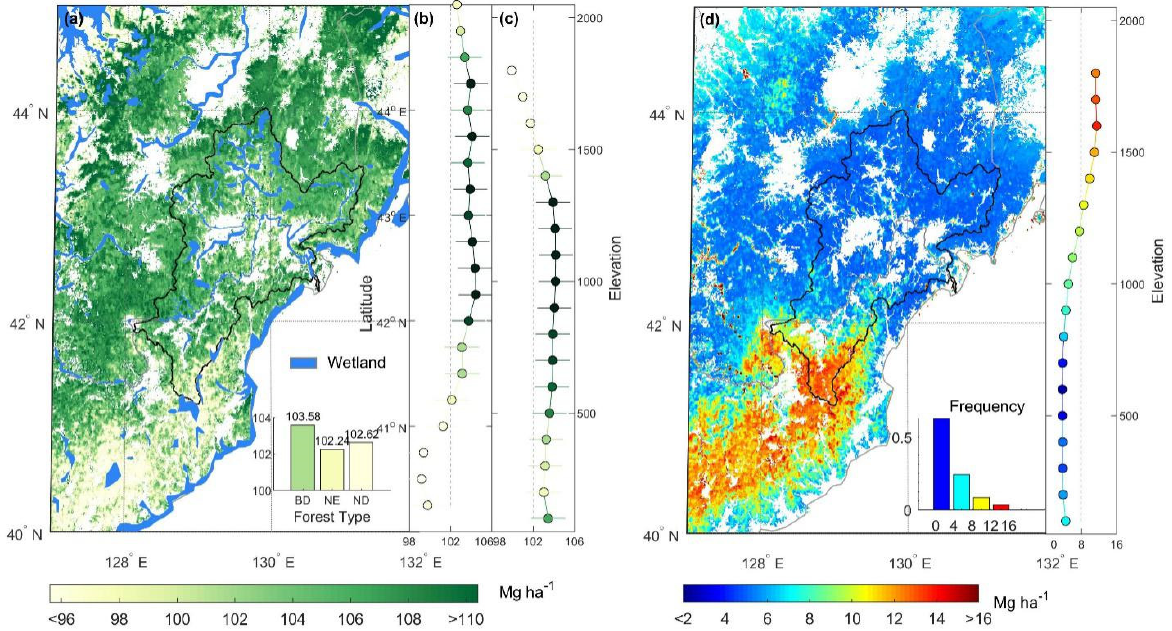
Figure 4. ( a ) The distribution of forest AGB in the Tumen River Basin in 2015, in which the inserted figure shows the average value of different vegetation types in the Tumen River Basin; ( b ) the distribution of forest AGB in the study area along the latitude gradient; ( c ) represents A line chart of the changes in the forest AGB along the elevation of the Tumen River Basin. ( d ) The distribution of uncertainty in Tumen basin and the uncertain distributions at different altitudes3.2. Effects of Wetlands on Forest AGB Climate Sensitivity.